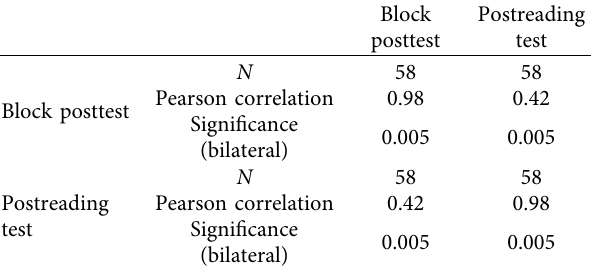
Table 4: Correlation analysis of posttest.